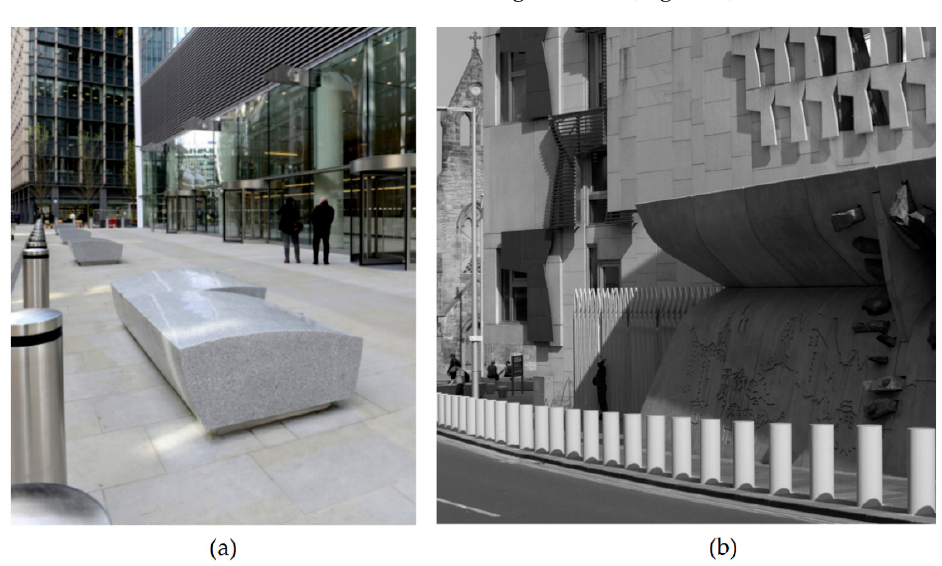
Figure 1. Anti-terrorist bollards and concrete barriers installed at the entrance to the building: ( a ) 20 Fenchurch Street in London, ( b ) The Scottish Parliament Building; phot. B&E Group,